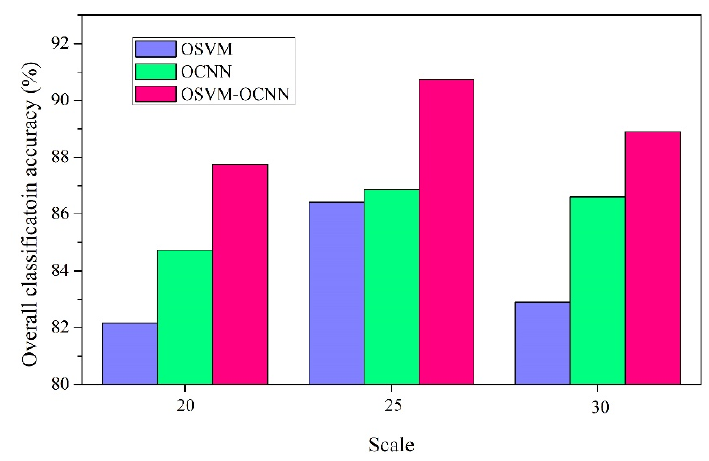
Figure 9. Classification accuracy of the OSVM, OCNN and the proposed OSVM-OCNN based on the multi-resolution segmentation (MRS) image segmentation results achieved with difference scale values.